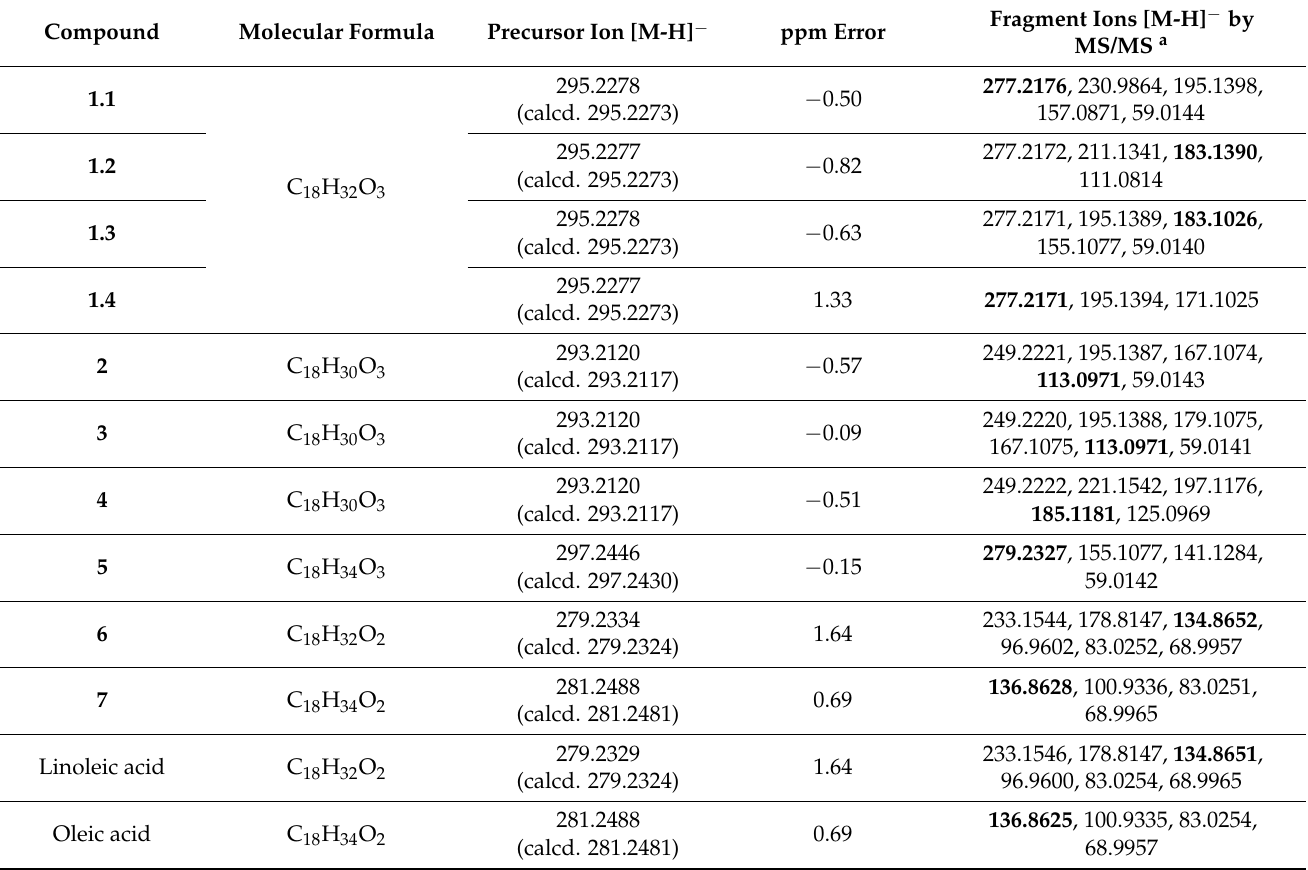
Table 1. HRMS (MS and MS/MS) analysis of fatty acids from O. tomentosa